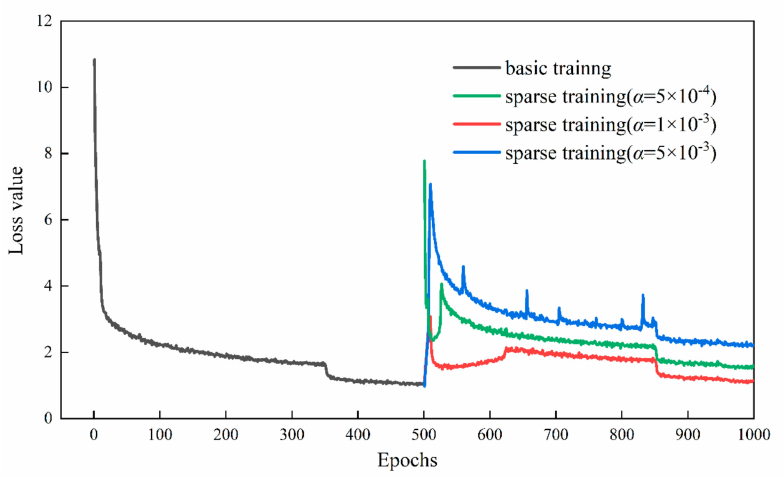
Figure 6. Training loss curve of sparse training with different constant coefficient- α . During the sparse training, the γ -values and their frequencies of occurrence were recorded using the Histograms function in the Tensor-board module in real-time. Figure 7 shows the distribution of the scaling factor γ -values in the BN layer, where the x -axis indicates the distribution of γ -values, the y -axis in Figure 7a,b displays the training epochs, and the other y -axis shows the number of network layers. As shown in Figure 7a, after basic training of 500 epochs, the distribution of γ -values for the BN layer was close to a normal distribution with a mean value of 1. As shown in Figure 7b, after sparse training of 500 epochs, the mode of the γ -values for the BN layer decreased from the initial 0.753 to 0.0442, gradually approaching 0, but not all values decayed to 0. Furthermore, the sparsity of γ -values remained unchanged when epochs were 200, so reducing α to the original 100 times would help the model performance rebound. As shown in Figure 7c,d, the distribution of γ -values for each network layer before and after sparse training is shown, respectively, and the sparse training compressed γ -values of channels with lower importance to near 0, which was convenient for later pruning